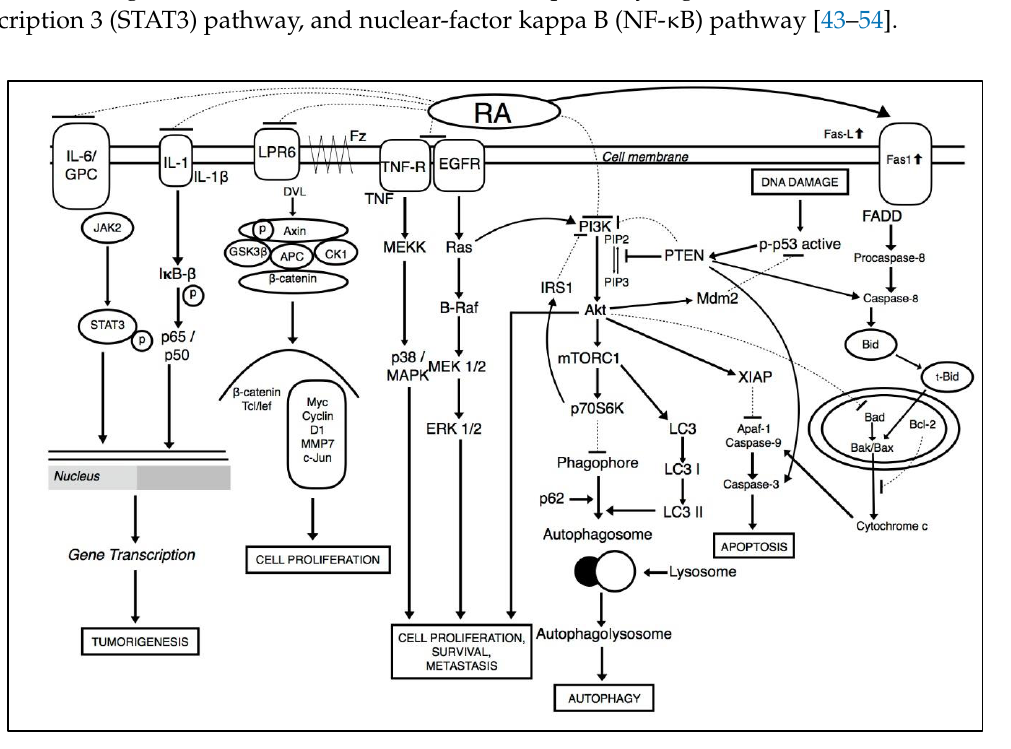
Figure 2. Multiple molecular pathways affected by RA.